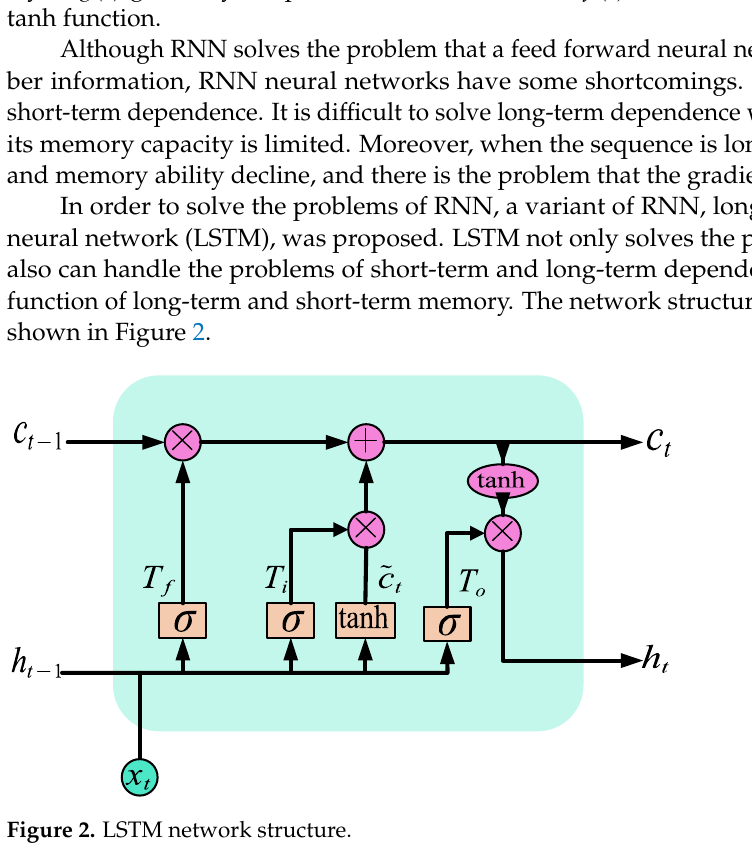
Figure 2. LSTM network structure.